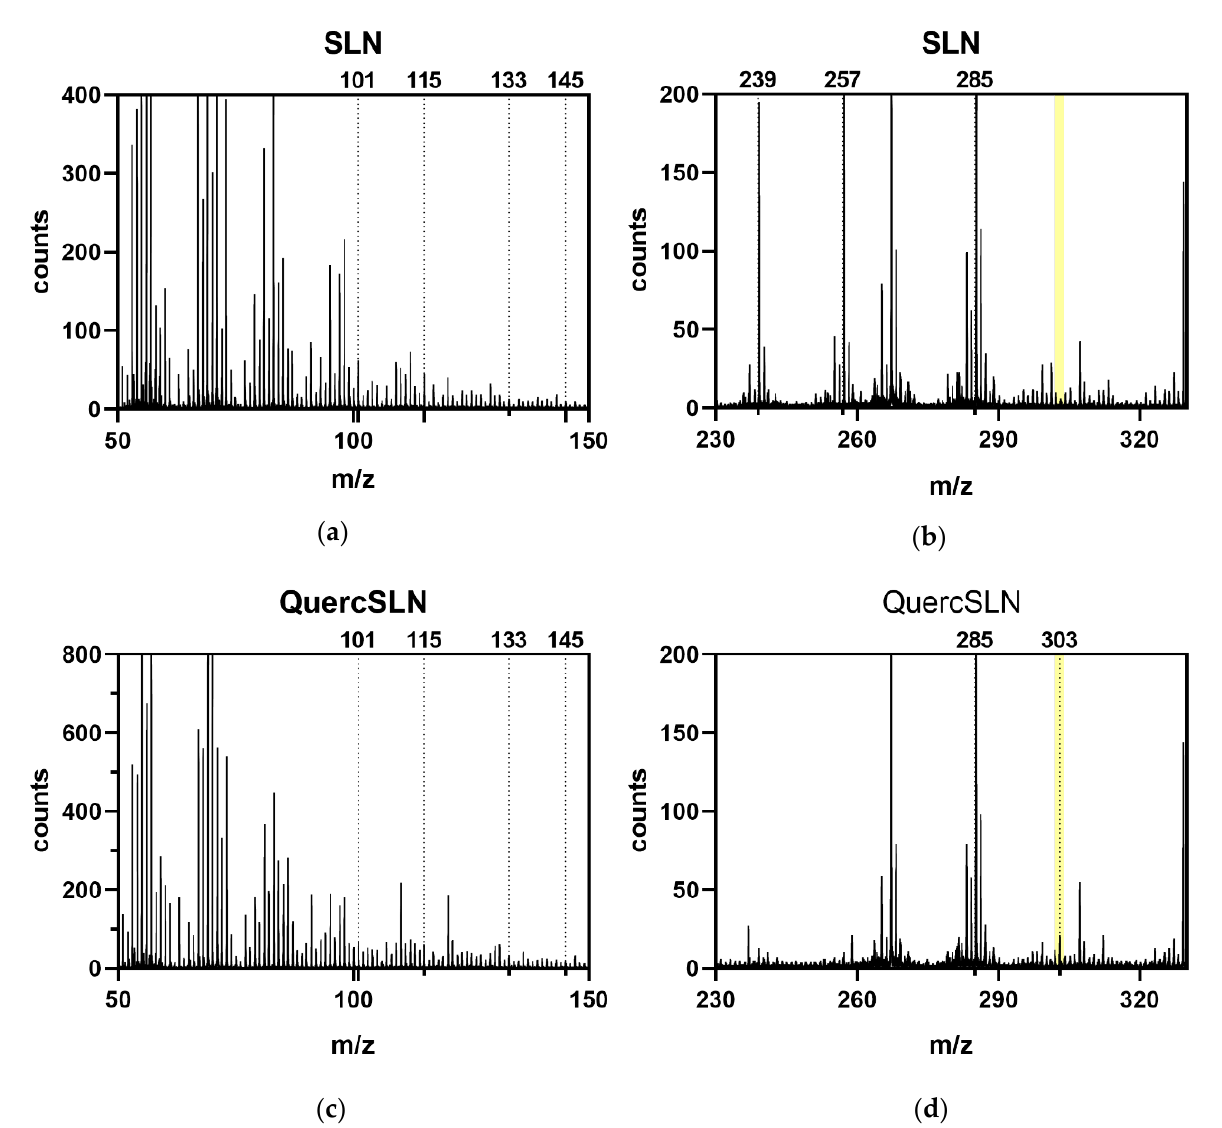
Figure 6. ToF-SIMS (positive ions) spectra extracts of SLNs ( a , b ), and QuercSLNs ( c , d ).